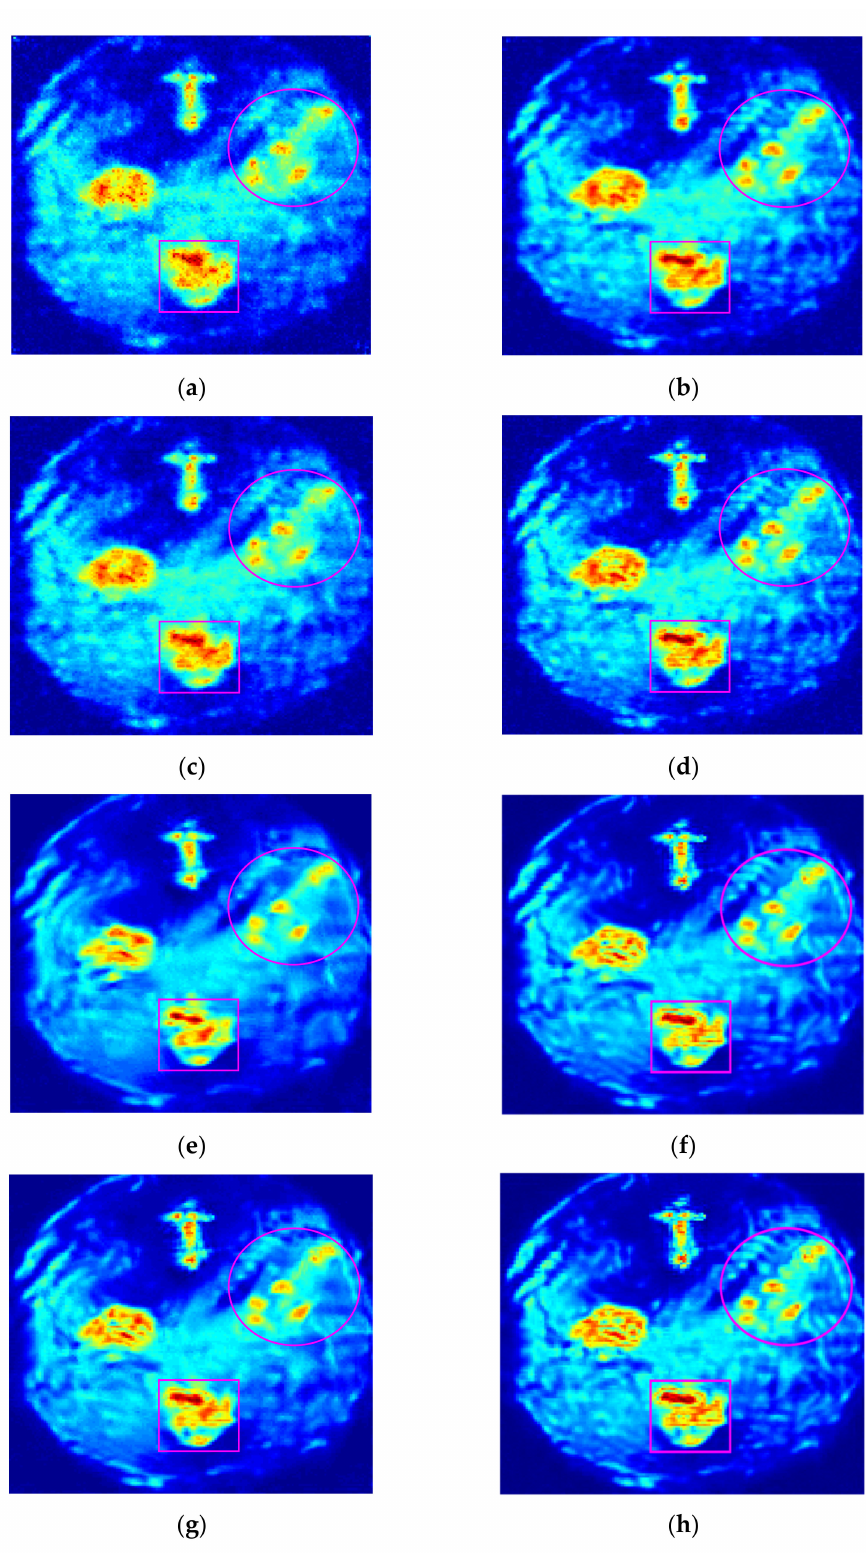
Figure 2. Reconstruction images of different methods for the sample at different sampling rates, and the areas marked by circles and squares are selected for detail comparison. ( a ) SSC at SR = 20%; ( b ) SSC at SR = 40%; ( c ) DSC at SR = 20%; ( d ) DSC at SR = 40%; ( e ) HSM at SR = 20%; ( f ) HSM at SR = 40%; ( g ) GSNS at SR = 20%; ( h ) GSNS at SR =